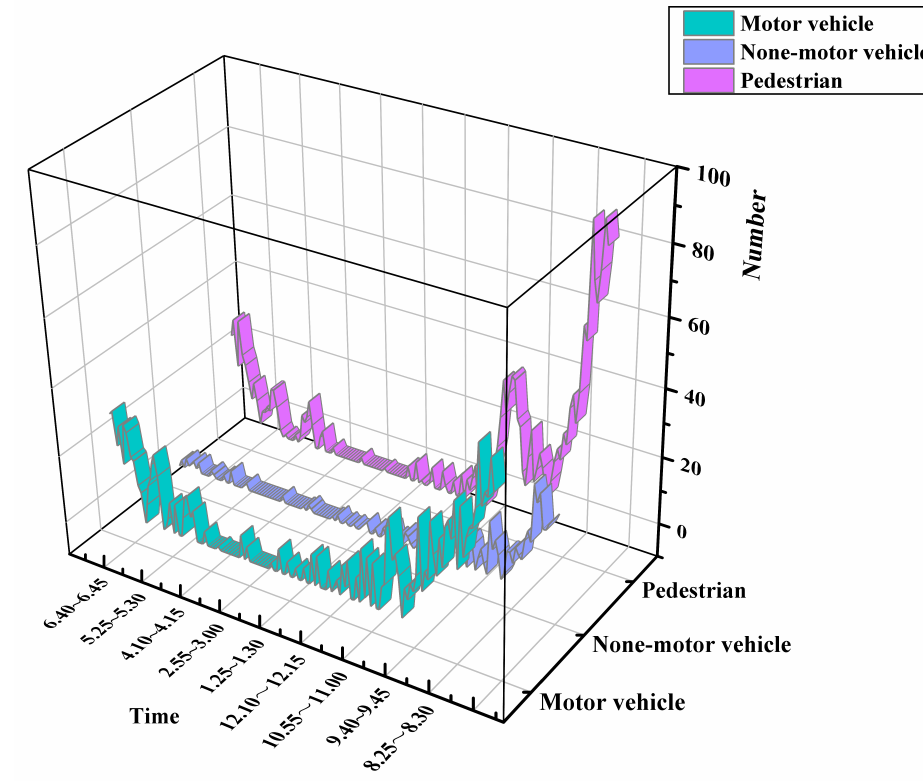
Figure 13. Traffic flow graph.